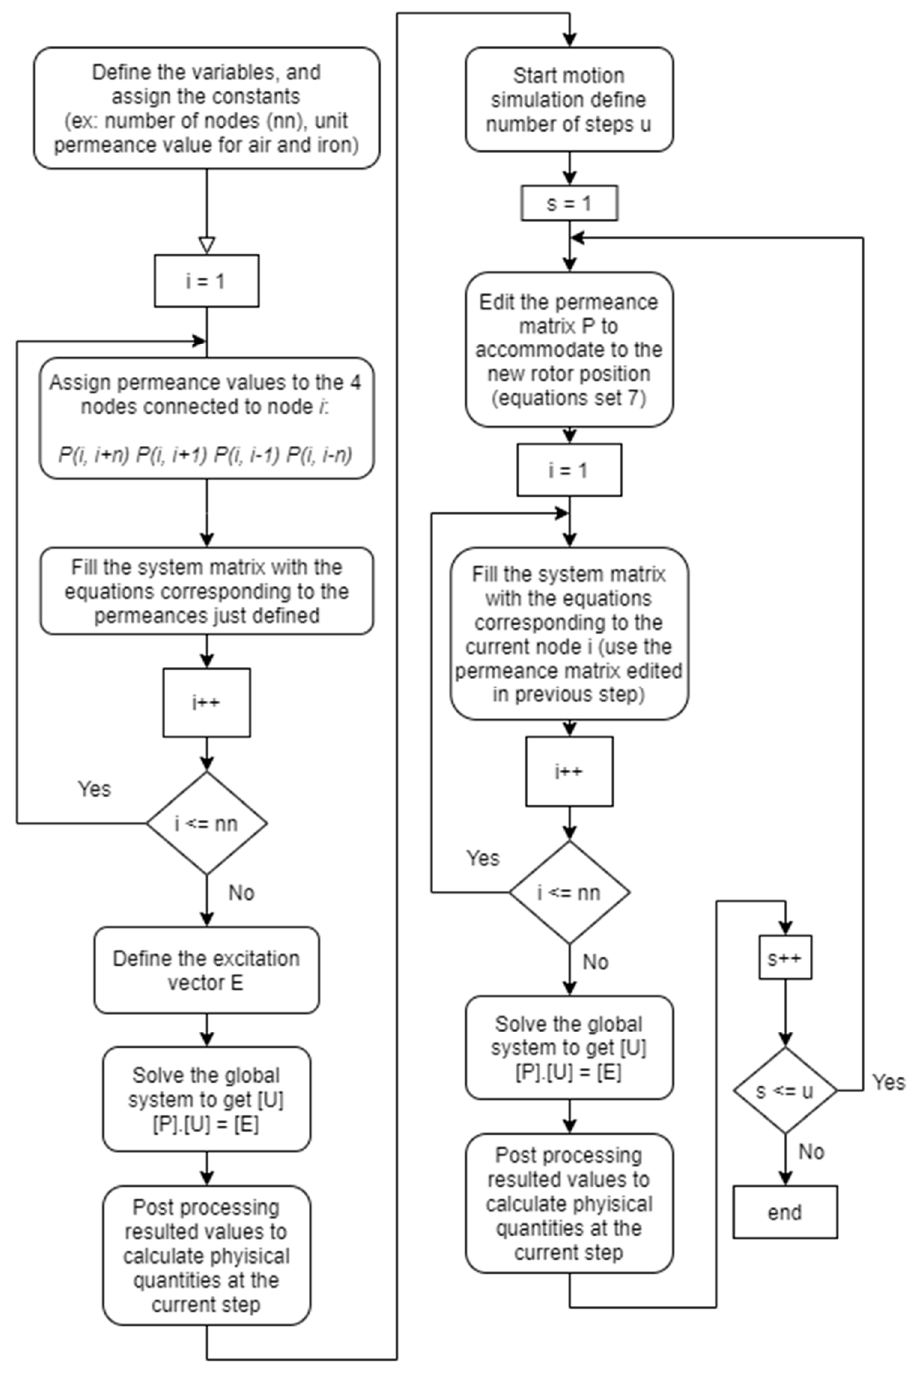
Figure A1. Flowchart of the 2D RN model software program.